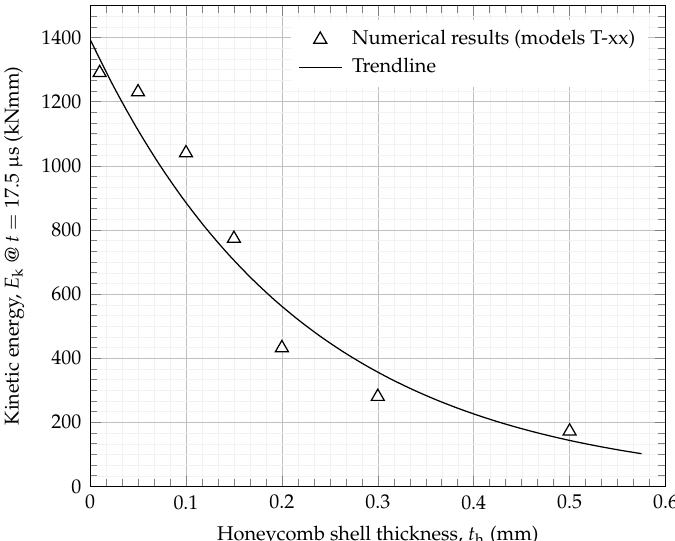
Figure 15. Kinetic energy of the debris particle at t = 17.5 µ s against thickness of the honeycomb shell.